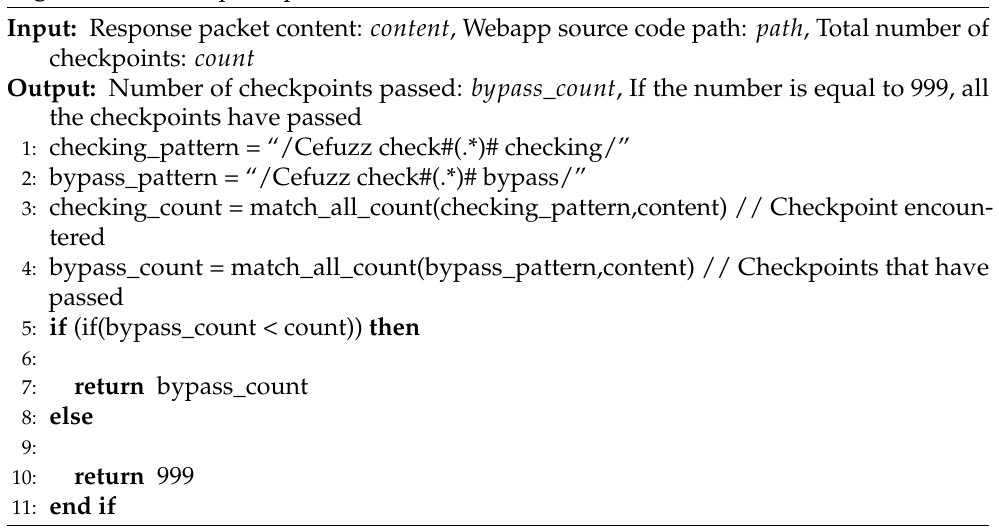
Algorithm 4 Checkpoint pass